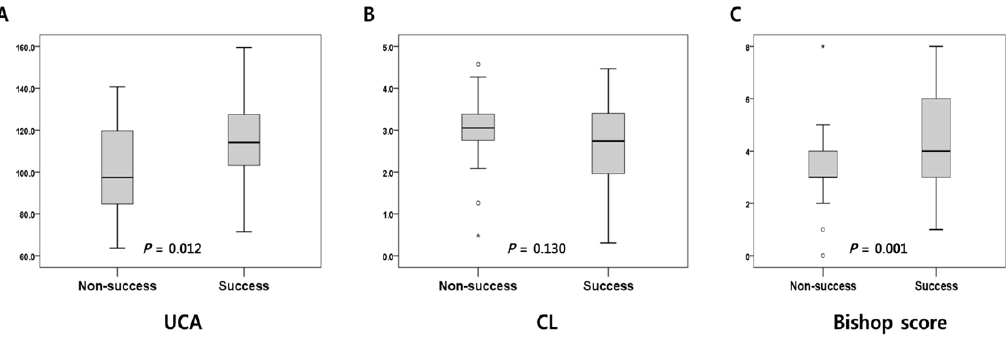
Figure 3. Value distribution of UCA ( A ), CL ( B ), and Bishop score ( C ). The boxes represent the interquartile range (IQR), with the upper and lower edges of the boxes representing the 75th and 25th percentiles, respectively. The central horizontal lines within the boxes represent the median levels for each group. The vertical whiskers above and below the boxes represent the range of outlying data points (up to 1.5 times the IQR). Asterisk(*): potential outlier; zero (°): outlier. A ROC curve was used to determine the efficacy of UCA as a predictor of successful IOL (Figure 4). The area under the curve (AUC) of Bishop score (0.718, 95% CI 0.600–0.837, p 0.002), CL (0.396, 95% CI 0.269–0.523, p 0.130), and UCA (0.658, 95% CI 0.521–0.795, p